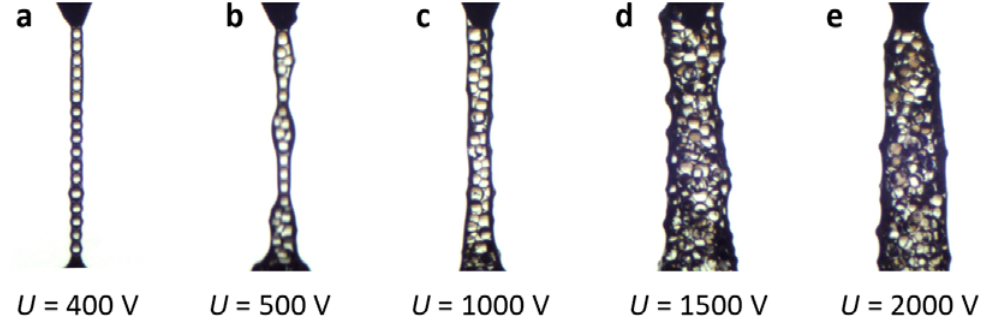
Figure 5. 1D structures made of aggregated PS particles sulfonated for 32 min. The structures were formed by pulling the particles out of silicone oil with a velocity of ~1 mm/s to a height of ~2.5 mm applying an electric voltage of ( a ) 400 V; ( b ) 500 V; ( c ) 1000 V; ( d ) 1500 V; and ( e ) 2000 V.